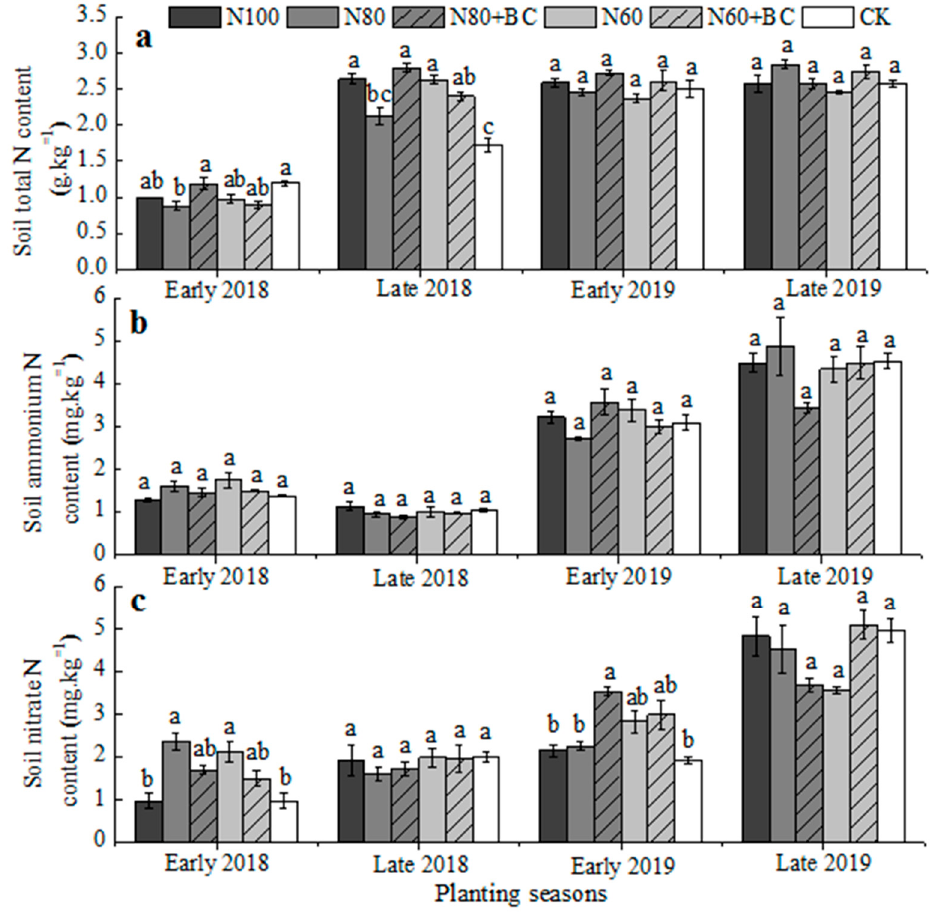
Figure 4. Effects of N fertilizer reduction combined with biochar application on total N ( a ), ammo- nium N ( b ), and nitrate N ( c ) in the soil. N100, 180 kg N·ha − 1 ; N80, 144 kg N·ha − 1 ; N80+BC, 144 kg N·ha − 1 + biochar; N60, 108 kg N·ha − 1 ; N60+BC, 108 kg N·ha − 1 + biochar; CK, no N and biochar application. Different small letters indicate significant differences among different treatments at the same planting season ( p < 0.05).